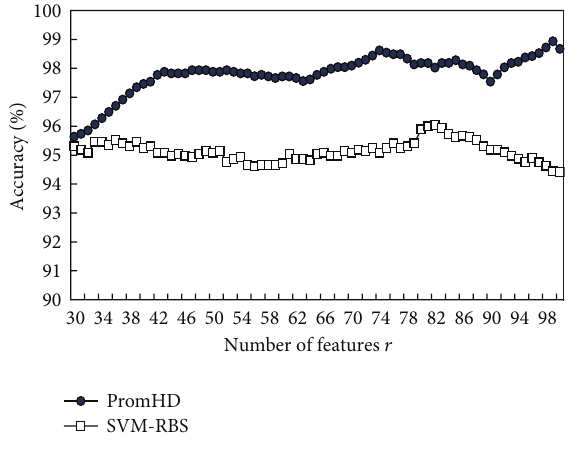
Figure 4: Training accuracies of the PromHD method and using SVM with a number 𝑟 of selected informative features for the HPL